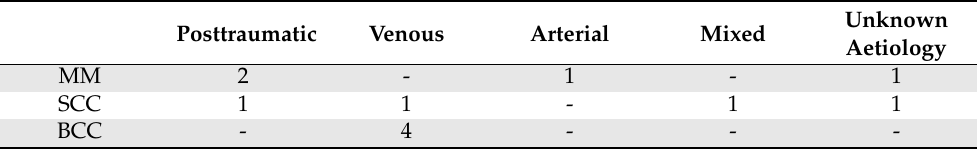
Unknown Aetiology